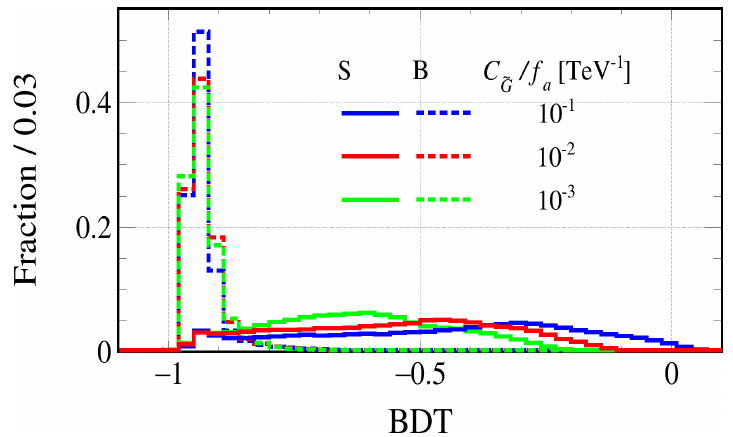
Figure 3 . BDT response distributions for total SM background and the signal with ALP mass m a = 500 GeV and three different ALP-gluon couplings, C ˜ HL-LHC with center-of-mass energy of 14